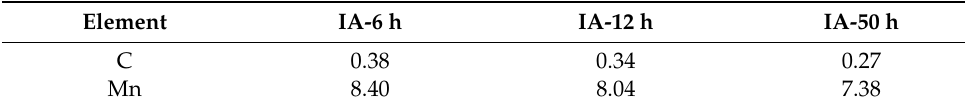
Table 3. TEM-EDS of C and Mn in PRA.